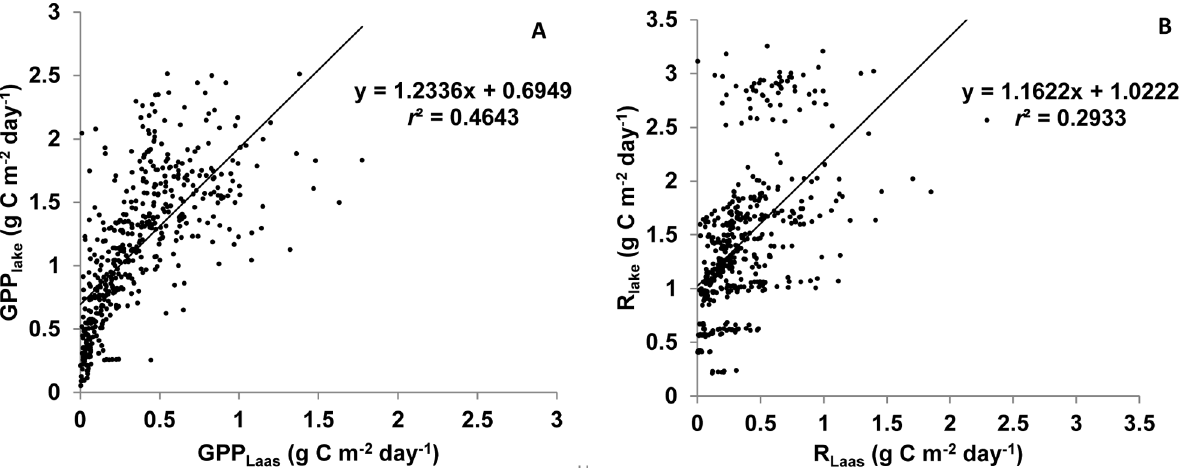
Figure 3. Scatter plot of GPP (A) and R (B) calculated in our study (GPP lake , R lake ) and measured in Laas et al. [26] (GPP Laas , R Laas ) from DO data during the ice-free seasons of 2009–2011 (n=480). Parameters are expressed in g C m 2 2 day 2 1